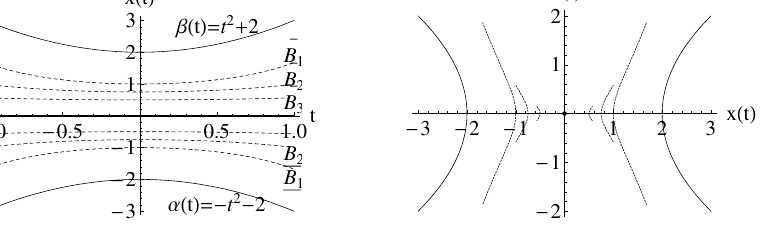
Figure 1. Monotone sequence converging to the unique (trivial) solution of the Neumann problem (2.3).